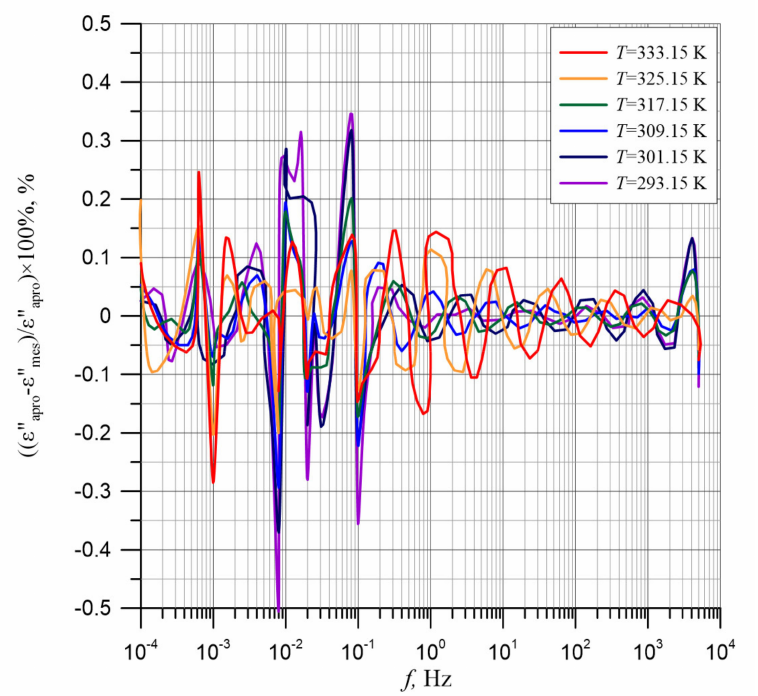
Figure 10. Percentage differences between the experimental imaginary permittivity component results for the composite of cellulose, transformer oil and water nanoparticles for temperatures from 293.15 to 333.15 K and polynomial approximation